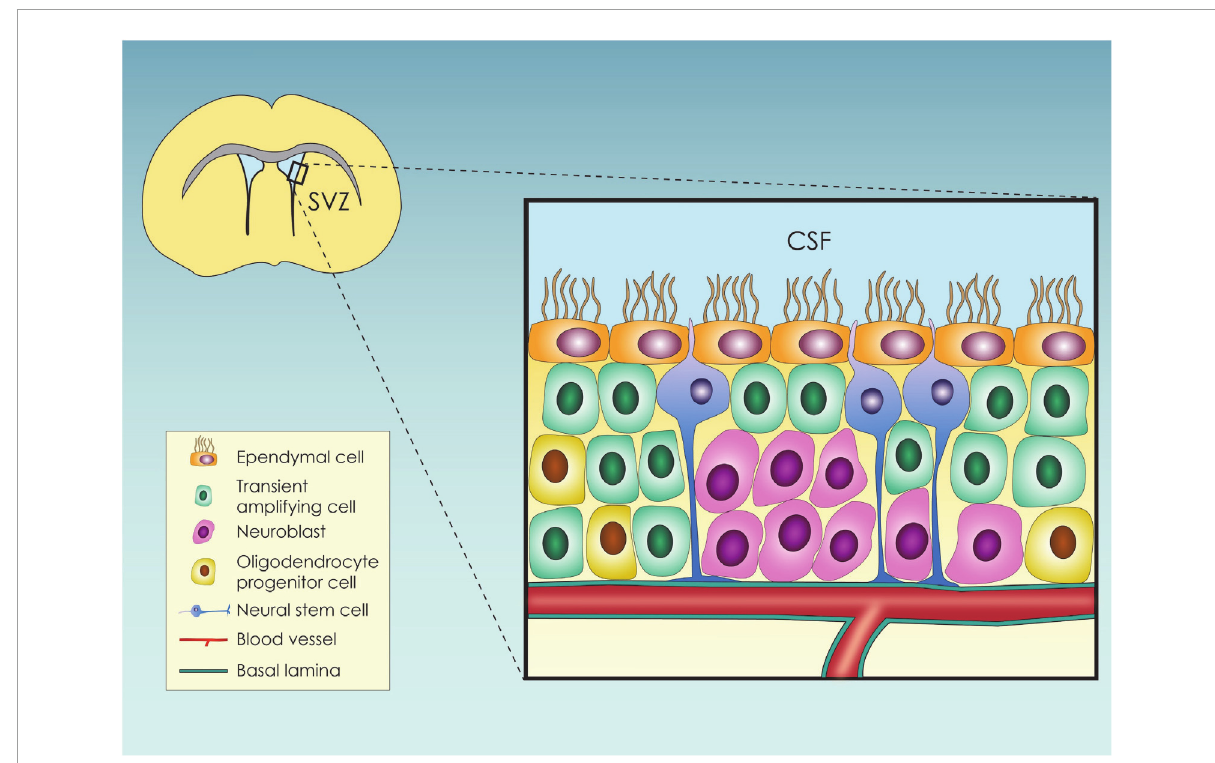
FIGURE1 Schematic representation of the subventricular zone (SVZ) neural stem cell niche and its cellular components; SVZ, subventricular zone; CSF, cerebrospinal fluid.